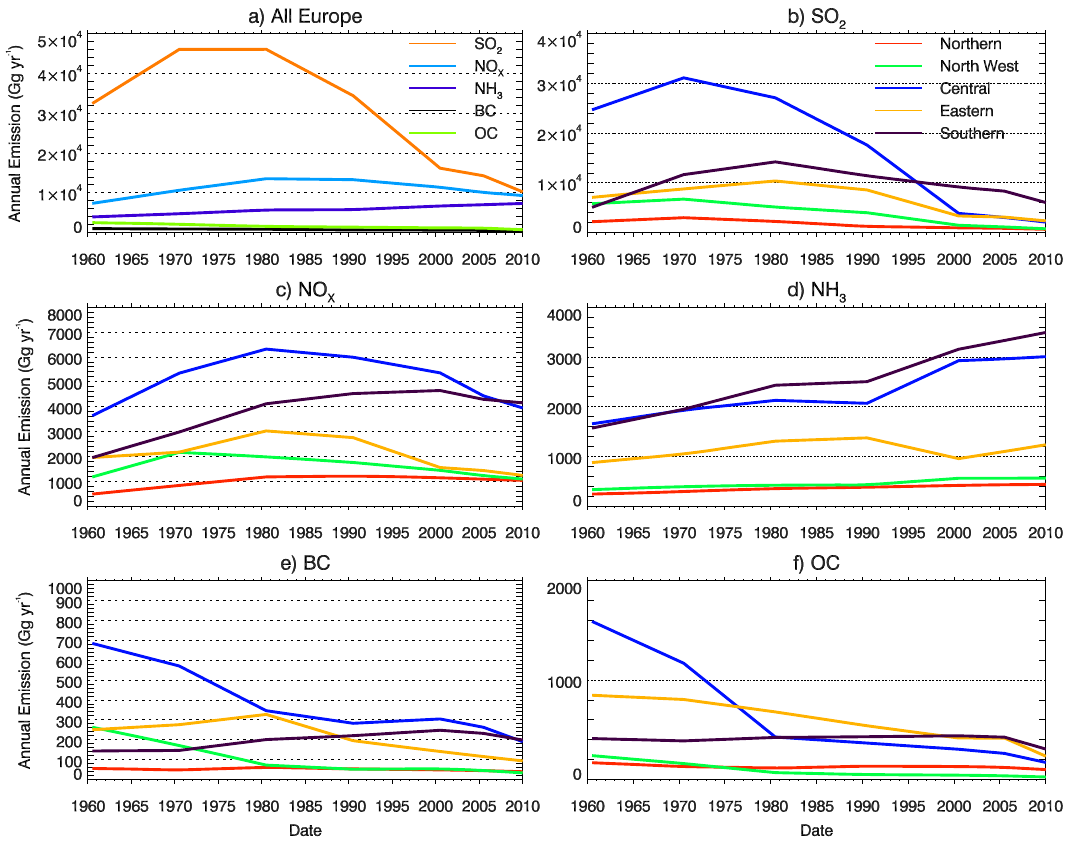
Figure 2. Annual European emissions (Ggyr − 1 ) of aerosols and aerosol precursors from the MACCity inventory over the period 1960–2009. (a) Total European emissions of sulfur dioxide (SO 2 , orange), organic carbon (OC, light green), black carbon (BC, black), ammonia (NH 3 , light purple) and oxides of nitrogen (NO X , blue). (b) – (f) show European regional emissions for (b) SO 2 , (c) NO X , (d) NH 3 , (e) BC and (f) OC. Regions are as defined in Fig. 1: northern (red), north-western (green), central (blue), eastern (orange), southern